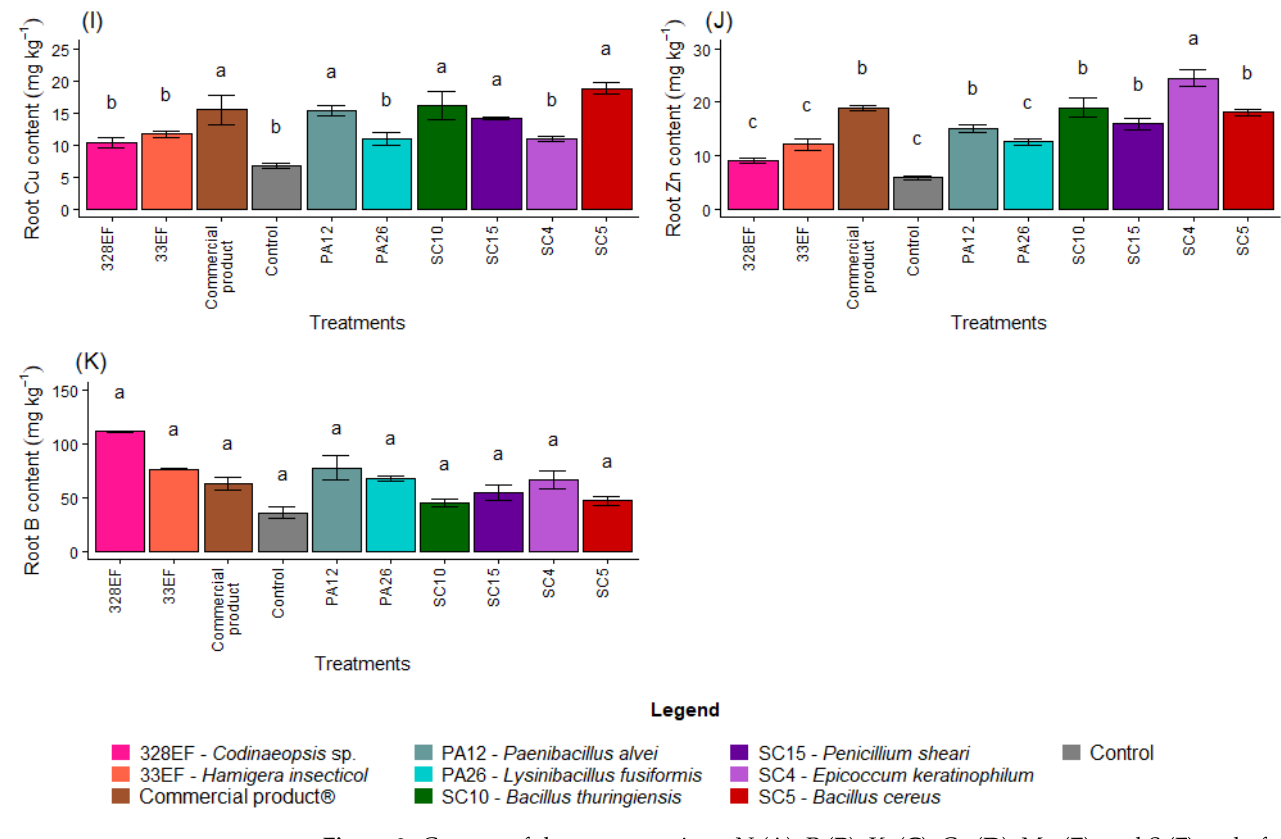
Figure 3. Content of the macronutrients N ( A ), P ( B ), K, ( C ), Ca ( D ), Mg ( E ), and S ( F ) and of the micronutrients Fe ( G ), Mn ( H ), Cu, ( I ), Zn ( J ), and B ( K ) in the roots of soybean ( Glycine max) plants inoculated with fungal and bacterial strains isolated from Hymenaea courbaril and Butia purpurascens and grown in a controlled greenhouse system. Means followed by the same letter were not significantly different using the Scott – Knott test at 0.05% probability.